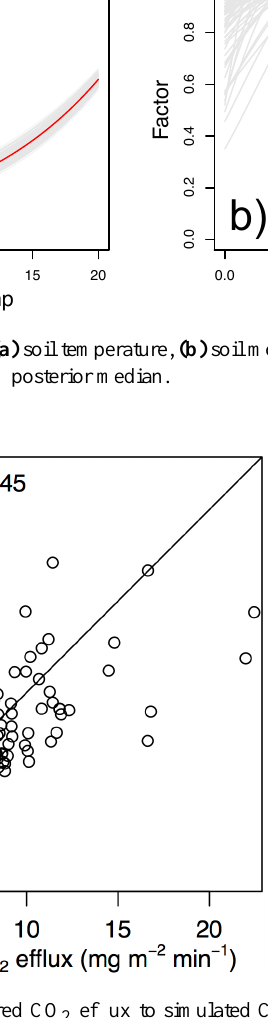
Figure 5. Response from measured CO 2 efflux to simulated CO 2 efflux by posterior medians in the HB model as a function of soil temperature, soil moisture, and thaw depth within a 40m × 40m plot (5m interval; 81 points) in Council, Seward Peninsula, Alaska during the growing seasons of 2011 and 2012.